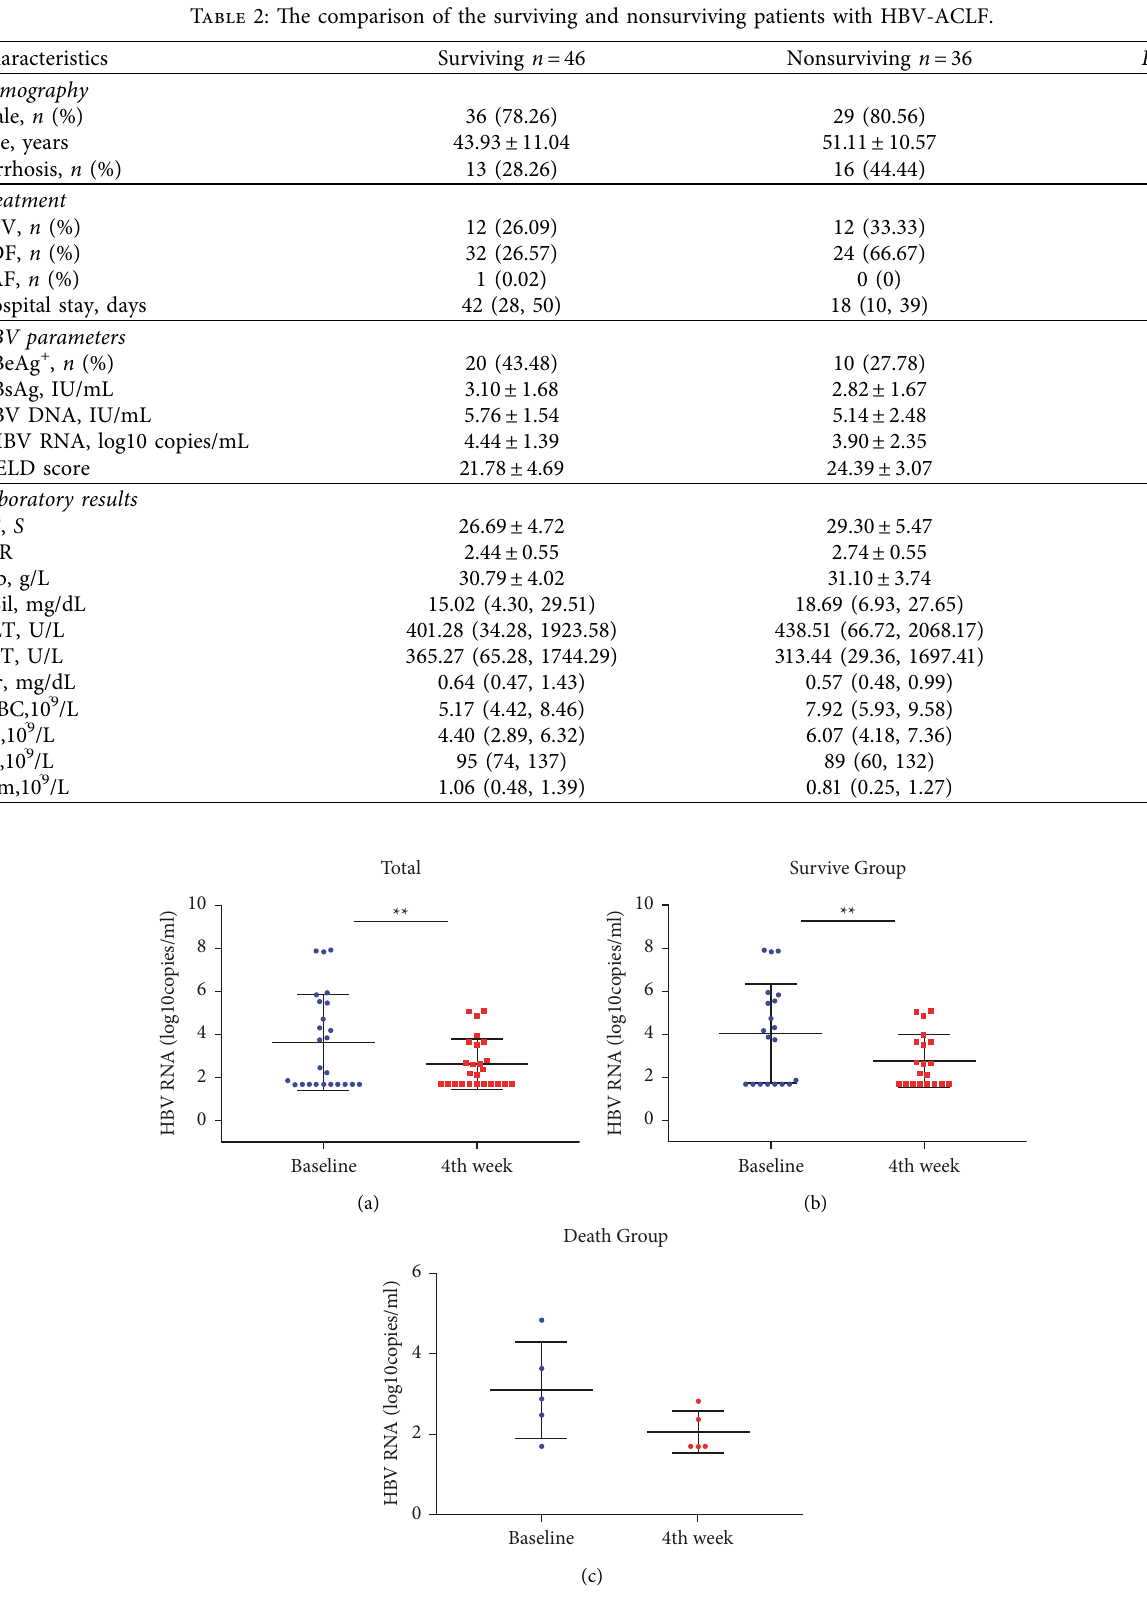
Figure 2: The serum HBV-RNA levels in the HBV-ACLF patients at baseline and on the fourth week. (a) The mean serum HBV-RNA levels (mean ± (SEM)) in 25 patients were significantly lower after four weeks of treatment relative to the baseline levels; the mean serum HBV- RNA levels in the survival group showed a similar pattern (b), but no significant difference was found in the death group (c); ∗∗ P < 0 .